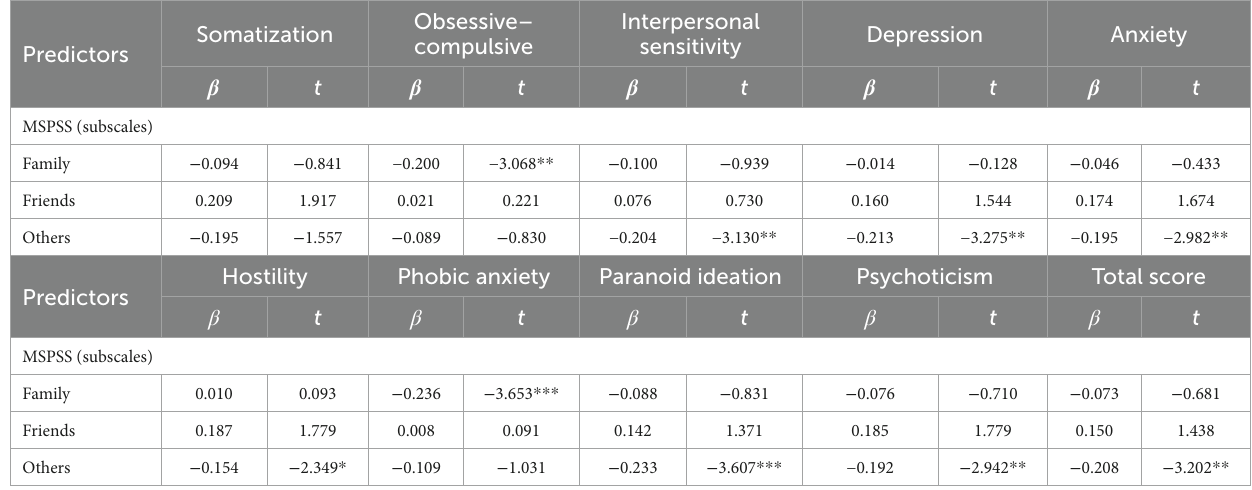
TABLE 5 The stepwise regression models of MSPSS subscales and each Dimension of SCL-90.